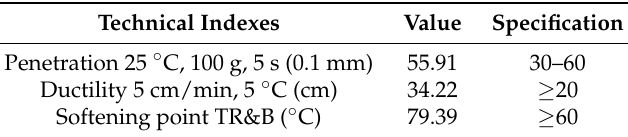
Table 1. The SBS-(I-D) modified asphalt performance.